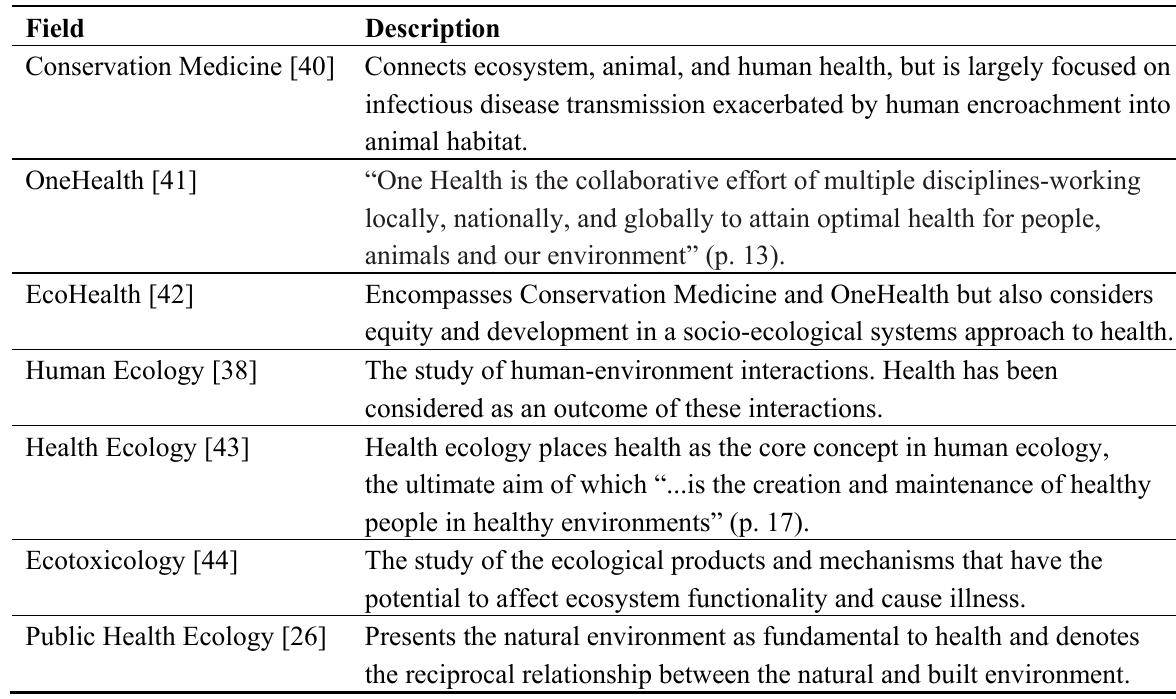
Table 1. Summary of fields that connect health and the natural